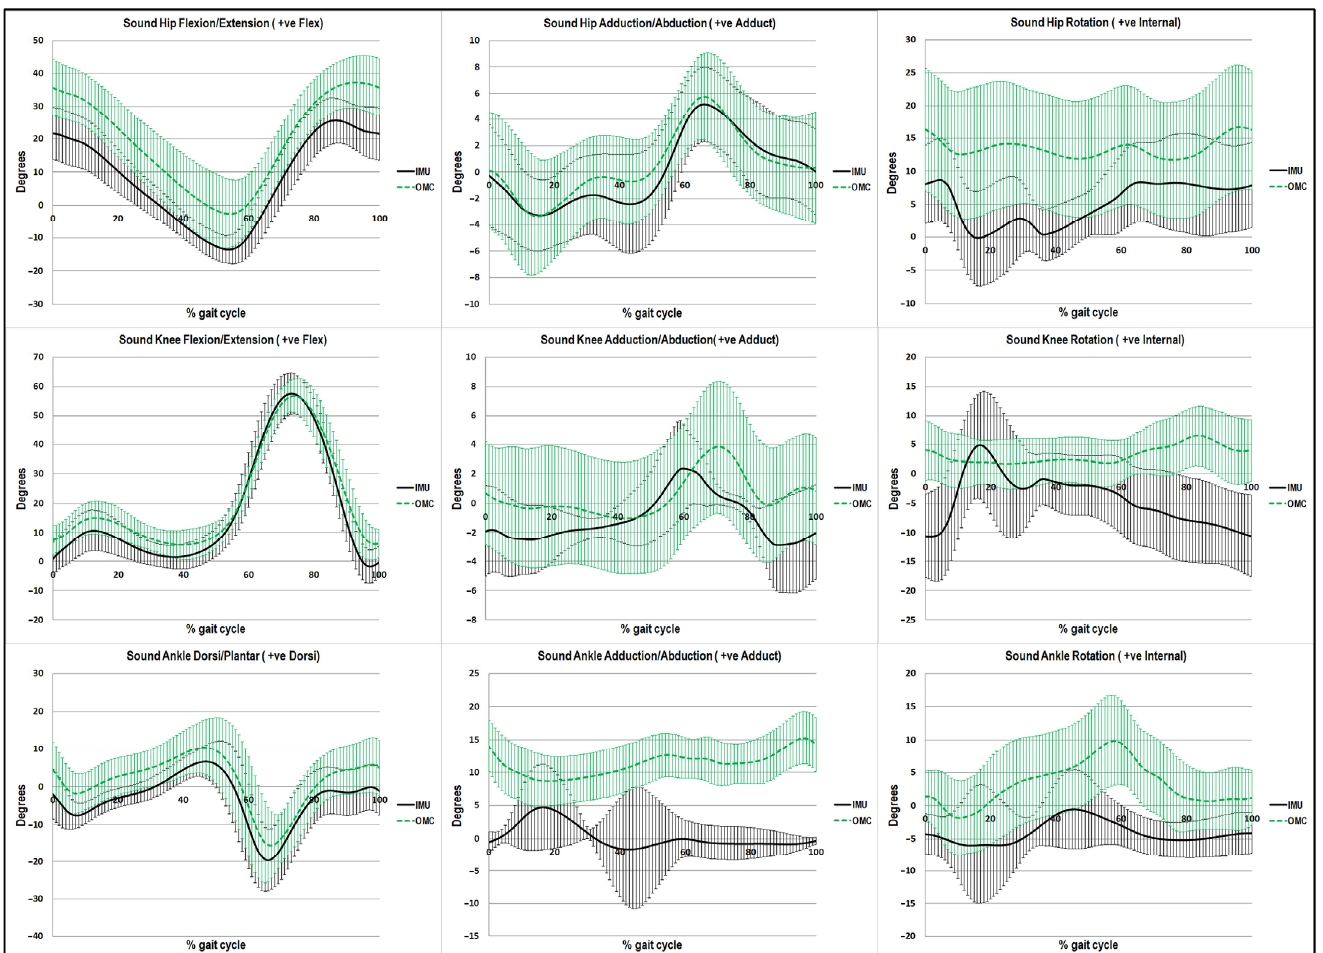
Figure 6. The visual waveform of walking kinematics on the sound side. The black lines represent IMU and the green lines represent OMC. Note: IMU: Inertial Measurement Unit, OMC: Optical Motion Capture.